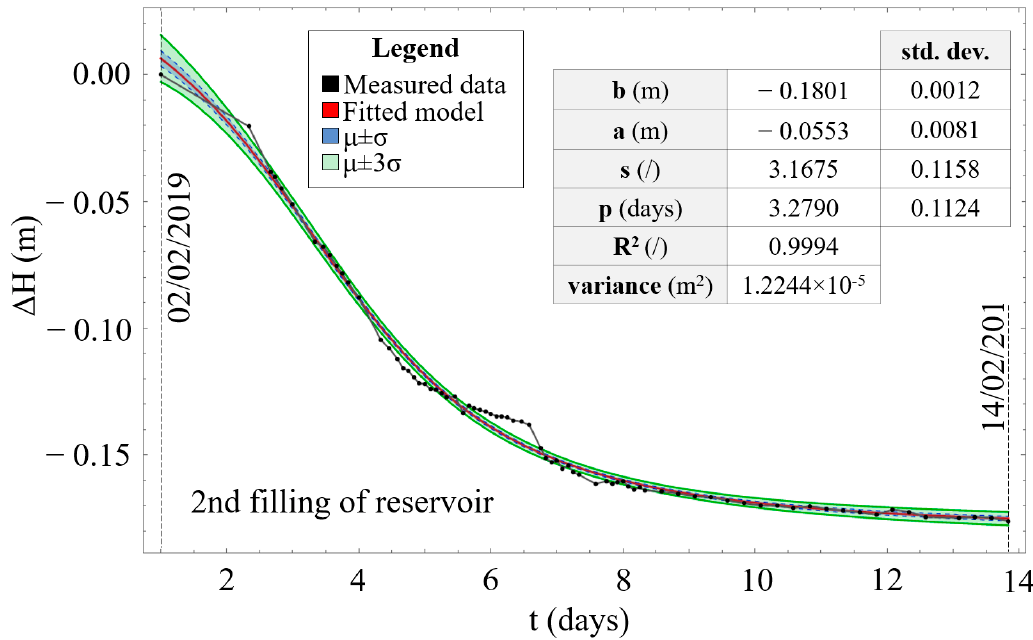
Figure 15. The fitted model for point MG19, based on obtained data from 02 / 02 / 2019 to 14 / 02 / 2019; actual data (black), best-fitted FNSE model (red), µ ± σ confidence interval (blue) and µ ± 3 σ confidence interval (green).